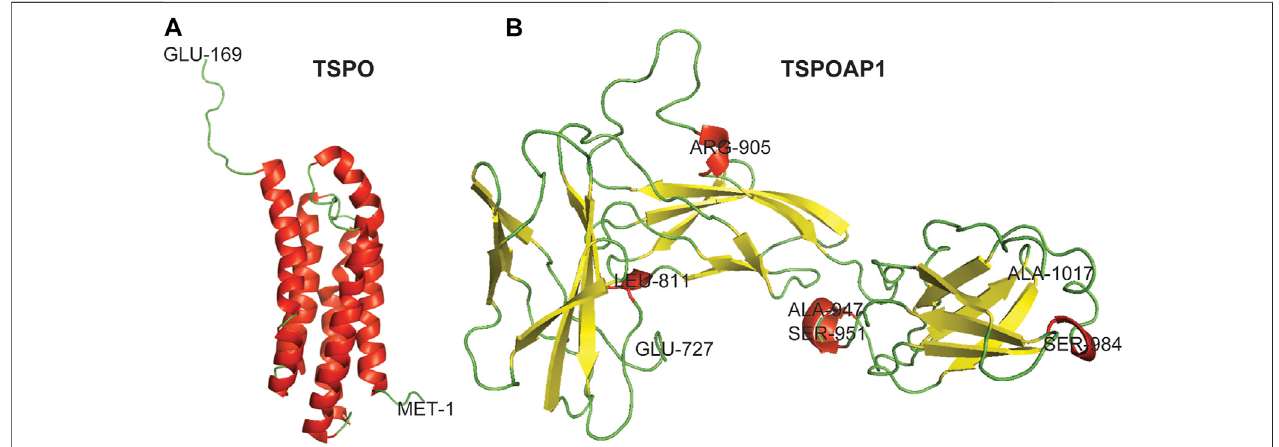
FIGURE 1 | Three-dimensional crystal structures of TSPO and TSPOAP1. Helix – Red, Sheet – Yellow, and Loop – Green.